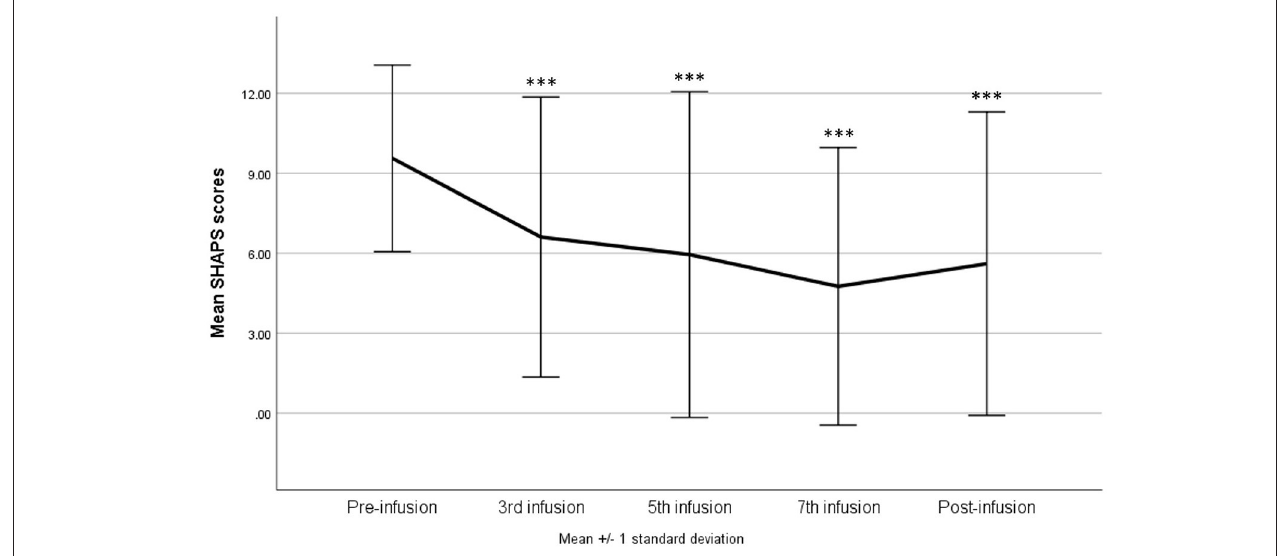
FIGURE 1 | Snaith–Hamilton Pleasure Scale (SHAPS) score change during ketamine treatment. *** p < 0.001 in comparison with baseline scores